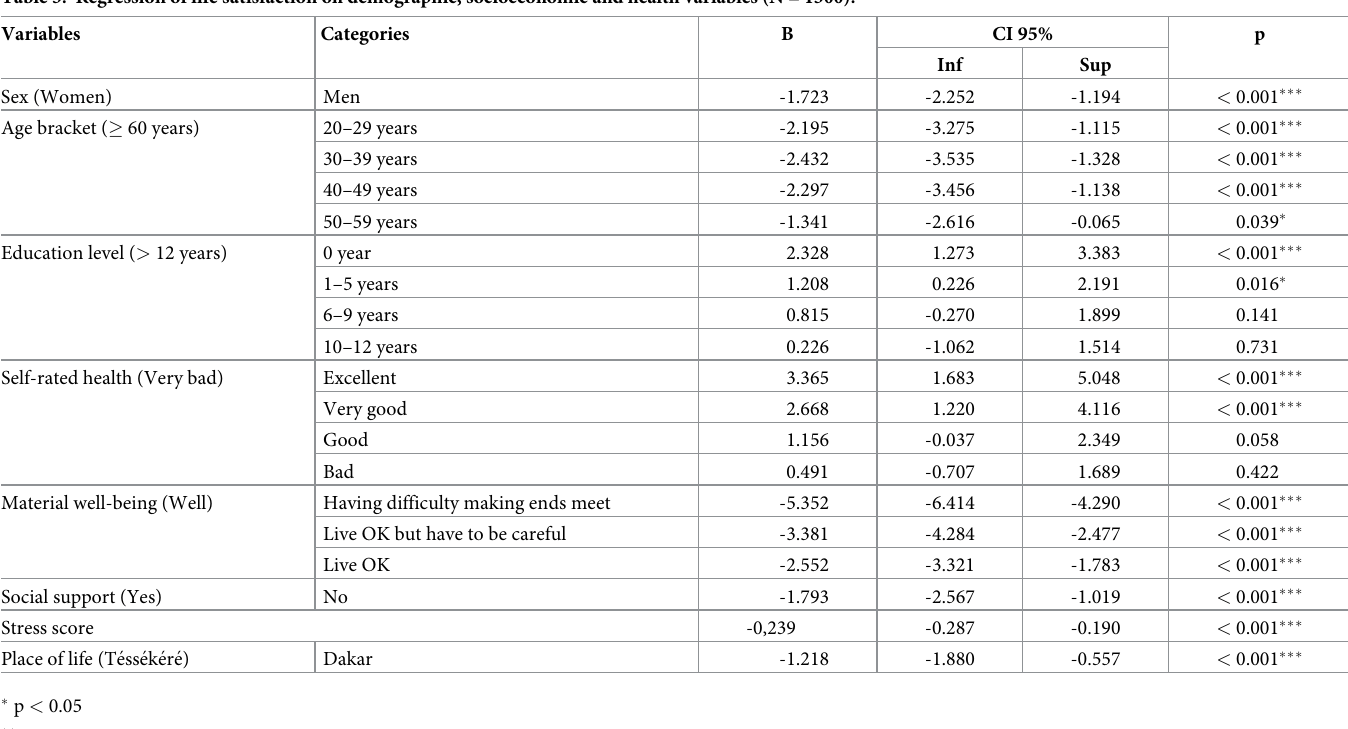
Table 3. Regression of life satisfaction on demographic, socioeconomic and health variables (N =